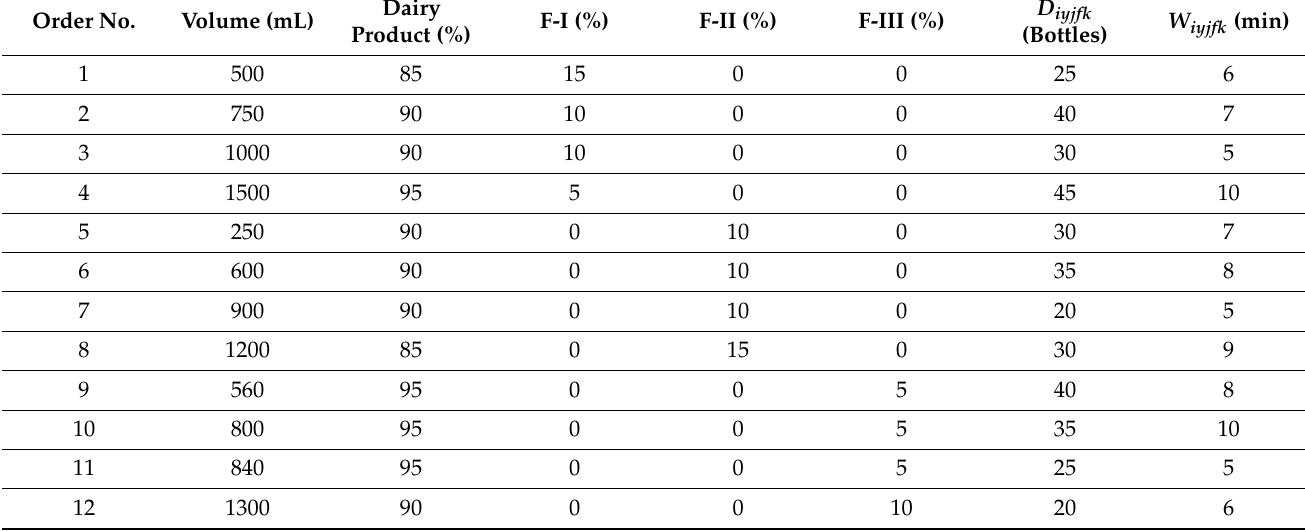
Table 2. Orders for dairy product (Type-I) mixed with three different flavors and the corresponding waiting